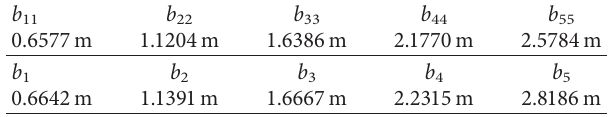
Figure 20: The 3-order super-harmonic amplitude-frequency response curve (a) with different excitation amplitudes; (b) different current- carrying. Table 1: The amplitude of considering aerodynamic force and not considering aerodynamic force (varied i , σ � 0).